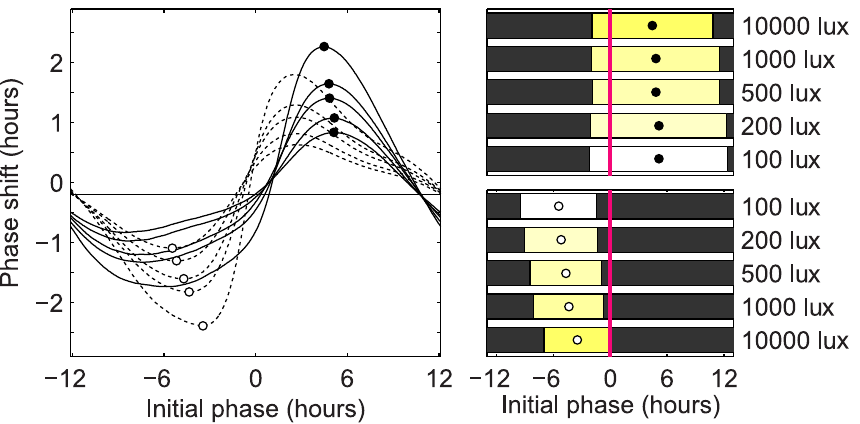
Figure 6. Optimal one-pulse stimuli to advance or delay the clock. We simulated the PRCs to all possible one-pulse stimuli for a variety of different light levels. For each light level, two stimuli were selected: the one producing the greatest advance and the one producing the greatest delay. The model was kept in total darkness before the stimulus was administered. Resulting phase shifts were measured using the concept of isochrons [22]. On the right the optimal advancing stimuli (top) and optimal delaying stimuli (bottom) are plotted for each light level. The bars indicate both the duration (bar length) and phase (midpoint) of the light stimuli relative to the timing of CBTmin (solid magenta vertical line). On the left the PRCs corresponding to each optimal stimulus length are plotted. On each PRC, the optimal phase maximizing the shift is marked by a circle (filled for advances and unfilled for delays). The PRCs corresponding to optimal advancing stimuli are drawn using solid lines, and ones corresponding to optimal delaying stimuli, using dashed lines. We found that, for low light levels and smaller shifts, the daily light exposures observed in the optimal schedules (See figures 4 and 5) matched the optimal one-pulse stimuli very closely. In particular, we find that the optimal advancing stimuli are much longer than the optimal delaying